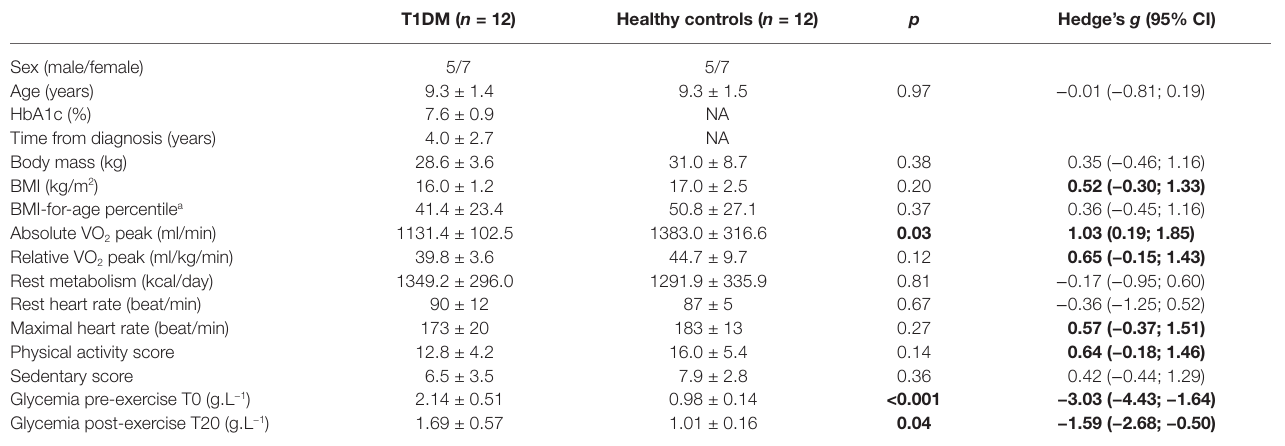
TABLE 1 | Participants’